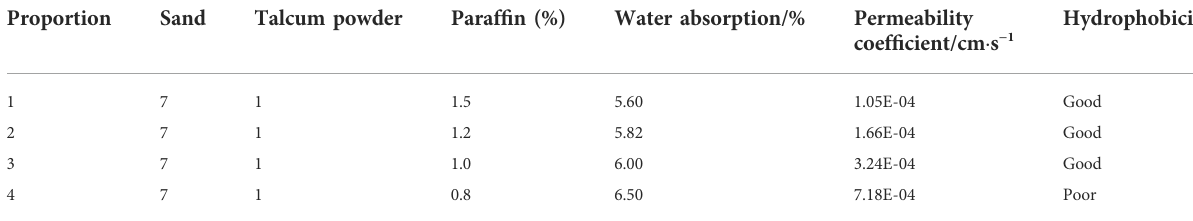
TABLE 1 Hydraulic properties of specimens with different ratios of similar materials.